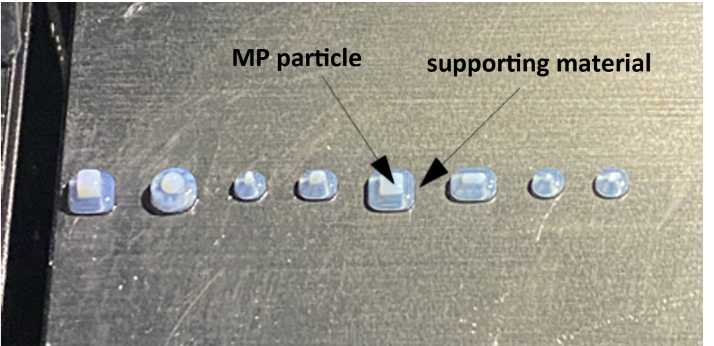
Figure 5. Example of printed MP particles (white) in the supporting material